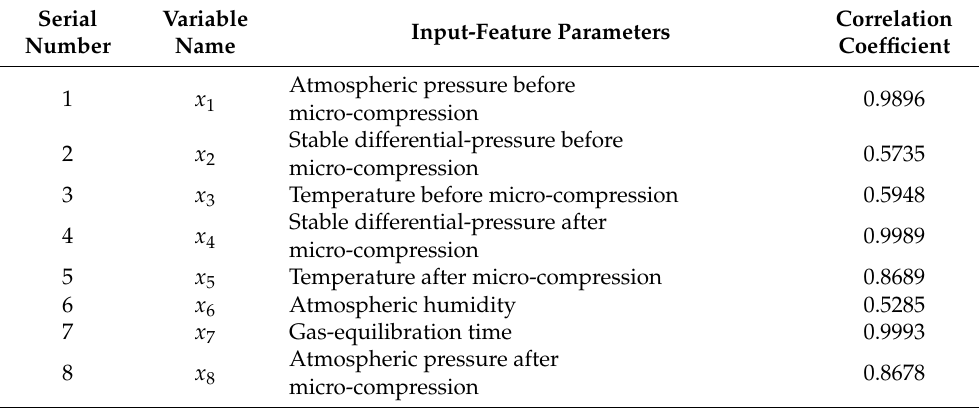
Table 1. Correlation coefficients of the